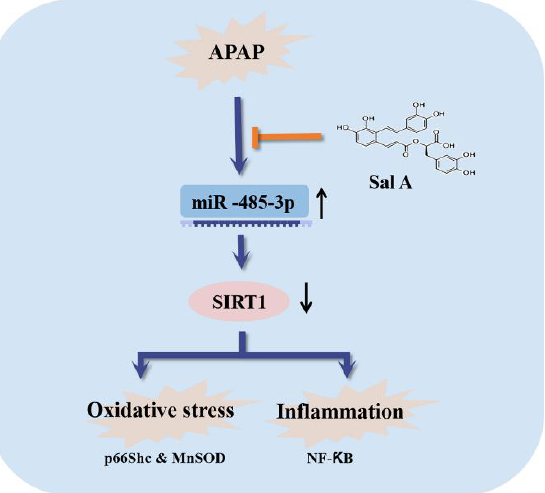
Figure 7. Sal A attenuates APAP-induced oxidative stress and inflammation by repressing miR-485- 3p-mediated inhibition of SIRT1.